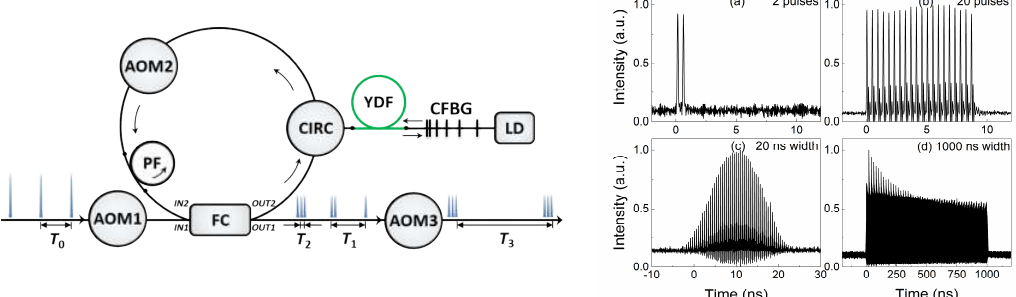
Fig. 1 Left: Schematic representation of an active fiber loop. Time delays: T 0 – between single input pulses, T 1 – between a delayed replica of an input pulse and an undelayed replica of the pulse, T 2 – intra-burst pulse separation of the formed bursts, and T 3 – between bursts of pulses. Right: Experimentally measured 2.2 GHz intra-burst PRR bursts containing from 2 (a) to about 2200 (d) ultrashort pulses. The active fiber loop was installed into the constructed 30 W-level average power ultrashort (sub- 1 ps) pulse laser system which operated in single-pulse and GHz-burst (2.2 GHz intra-burst PRR) operation regimes. A detailed description of a new pulse multiplication technique and the demonstration of its versatility in industrial-grade high-power laser will be provided at the